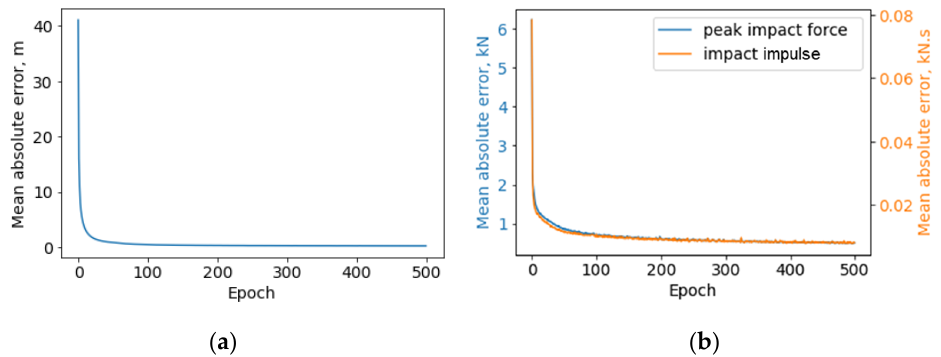
Figure 15. Artificial neural network learning curves: ( a ) impact location, ( b ) impact force. Table 3. Neural network model testing results.